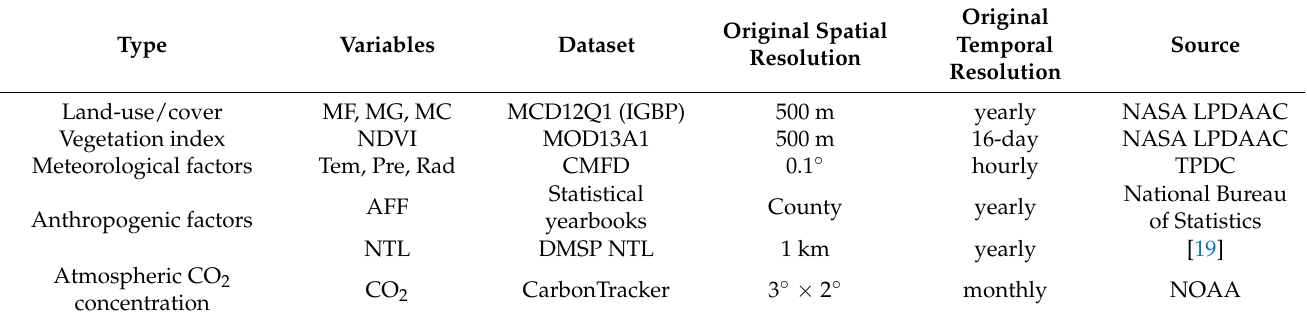
Table 2. Datasets used in this study.